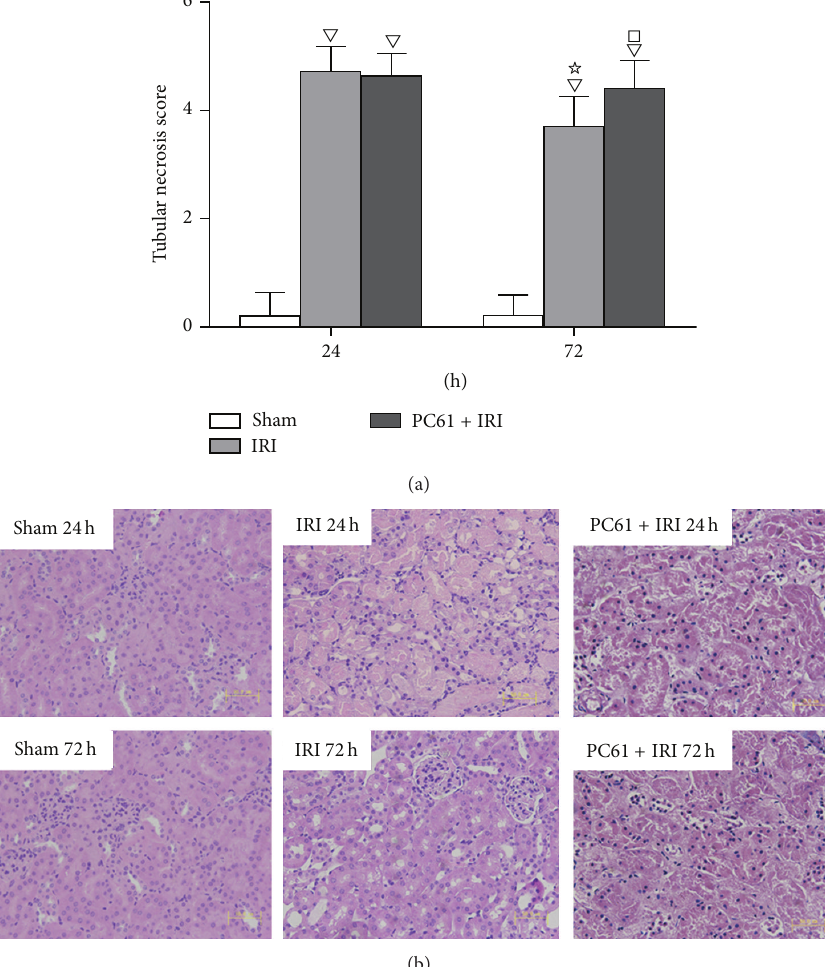
Figure 2: Renal histology at 24 h and 72 h after reperfusion. (a) Tubular necrosis scores in each group. Values of the bar graphs represent the mean ± SD ( 𝑛 = 8 per group). Compared with the Sham group, 󳶚 𝑃 < 0.05 ; compared with the IRI group at 24 h after reperfusion, f 𝑃 < 0.05 ; compared with the IRI group at 72 h after reperfusion, ◻ 𝑃 < 0.05 . (b) Representative histology images of H&E stained renal sections at 24 h and 72 h after reperfusion (original magnification: × 400, scale bar: 50 𝜇 m). After IRI, a large number of tubular epithelial cells swelled with vacuolar degeneration, parts of the cells shrunk and had dark nuclei, parts of the cells lost intracellular structure due to cellular necrosis and abscission, and cellular debris and casts were seen in the enlarged